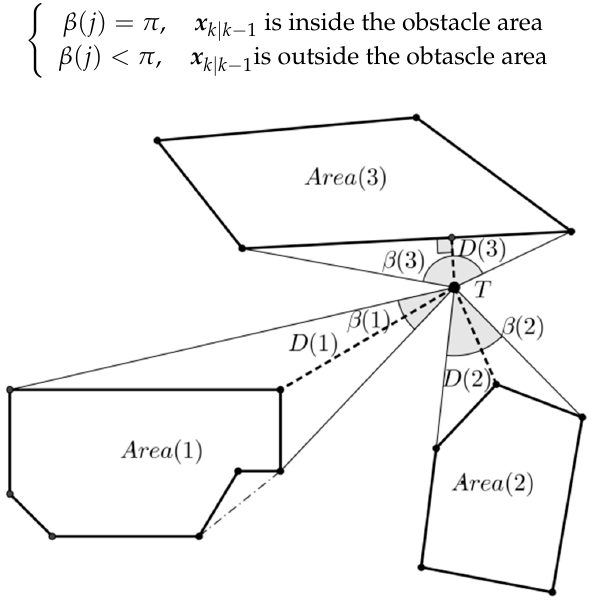
Figure 4. Distance between x_(k|k − 1) and obstacle convex polygons (D(3) < (D(1), D (2))); field angle between x k | k − 1 and obstacle convex polygons ( β ( 3 ) > ( β ( 1 ) , β ( 2 ) )).